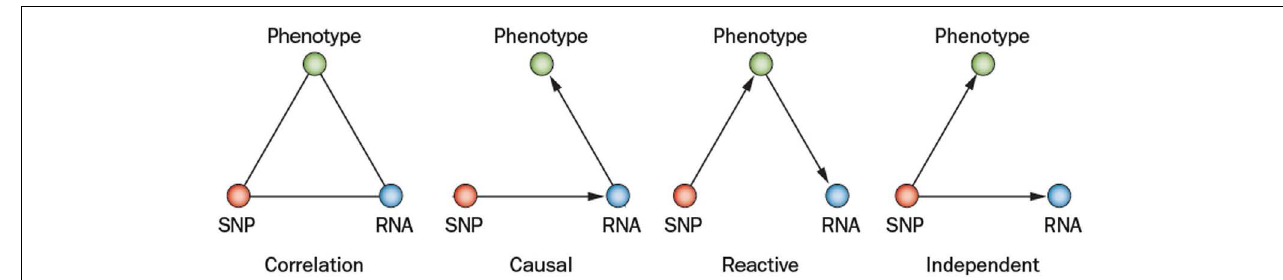
transcript levels leading to the resulting phenotype. In the reactive model, the SNP acts on the phenotypes, which in turn affects transcript. In the independent model, the SNP variation acts on both the phenotype and transcript independently (Schadt et al., 2005; Aten et al.,